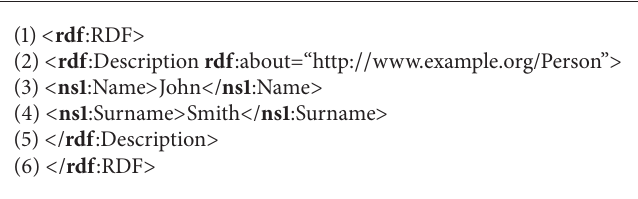
Algorithm 2: Pseudocode of the Person description in RDF.